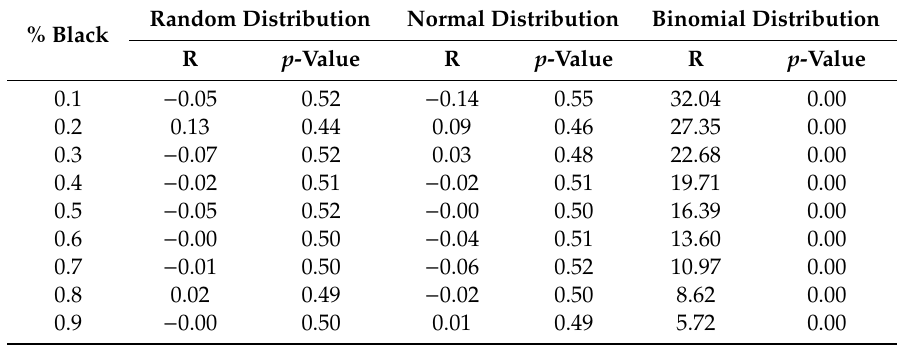
Table 2. Impact of black ratio with Voronoi-based sliding window model. Random Distribution Normal Distribution Binomial % Black